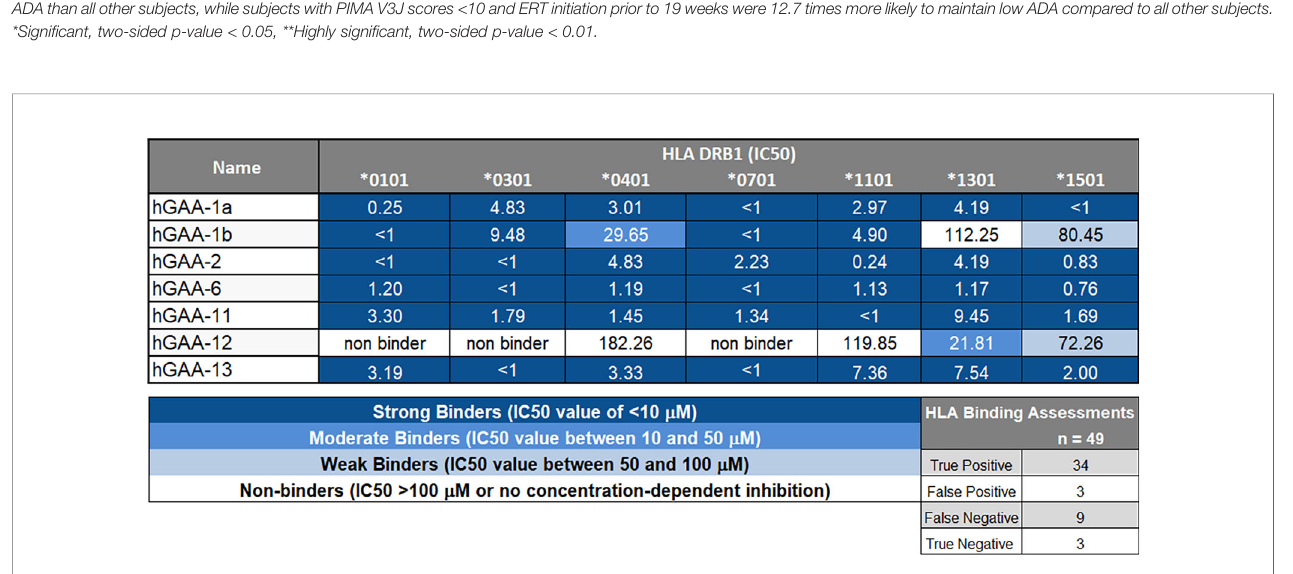
FIGURE 4 | GAA-peptides bind to HLA DR1 as predicted.Selected GAA peptides were evaluated for HLADRB1 binding invitro and IC 50 values were calculated. hGAA-1a, hGAA-1b, hGAA-2, hGAA-6, hGAA-11 and hGAA-13 FV621 peptides bound with the multiple alleles tested (DRB1*0101, *0301, *0401, *0701, *1101, *1301 and *1501)whereas hGAA-12 was predicted to bemore HLA-restricted and consequently had limited binding to HLA. A seven-point competition assay using a validated control peptide was performed; color coding re fl ects binding af fi nity IC 50 was determined byinterpolation.Using a standard Z-score thresholdof1.64 (top 5%), overallpositive predictive value for EpiMatrix predictions was 92%,with sensitivity of79%.False negatives are not uncommon when testing peptides containingsigni fi cant predictionsfor several alleles (EpiBars), as manycontain “ near-miss ” Z-scores in the top10% ofpredicted peptides. Note that peptide GAA-12 and 13 werenot selected for promiscuity: they were designed for individualized testingina speci fi c patient for which both the mutation and the HLADRB1 allelerestriction concurred.